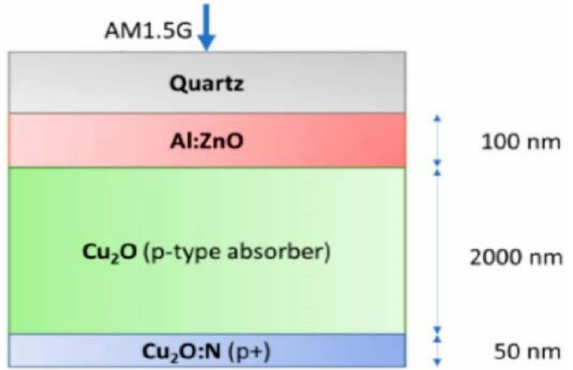
Figure 16. Diagram of the simulated Cu 2 O/AZO solar cell